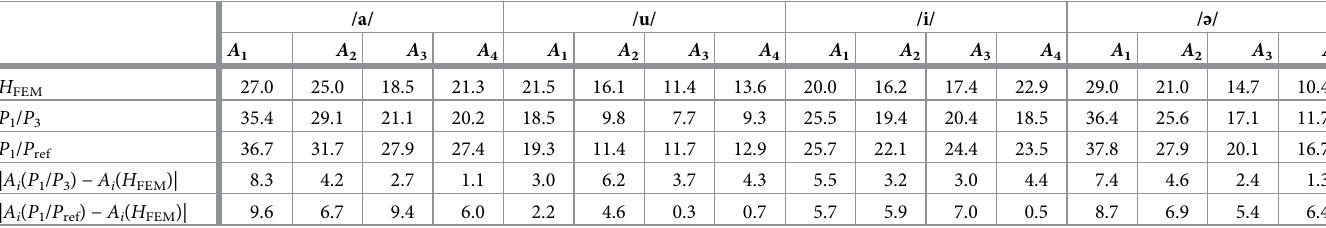
Table 3. Amplitudes in dB of the simulated and measured transfer functions and their absolute deviations in dB. /a/ /u/ /i/ A